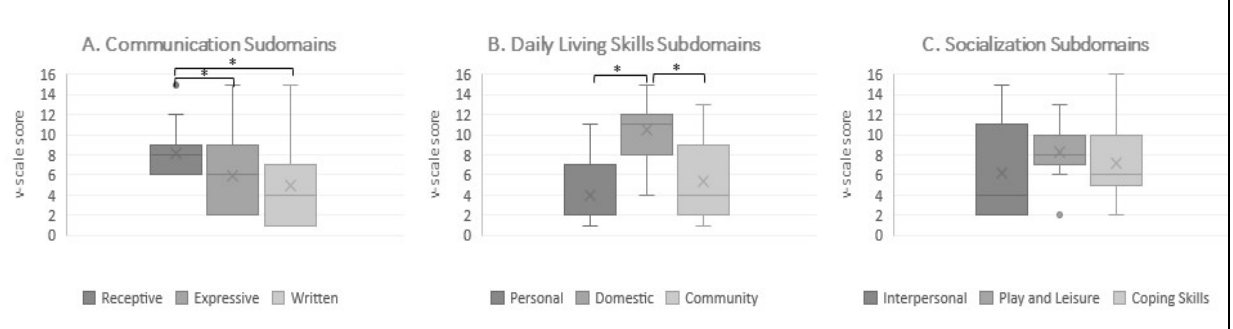
Figure 2. Intradomain comparisons ( A ) Box plots of v-scale scores of Communication subdomains ( B ) Box plots of v-scale scores of Daily Living Skills subdomains ( C ) Box plots of v-scale scores of Socialization subdomains, * significant at p ≤ 0.05.